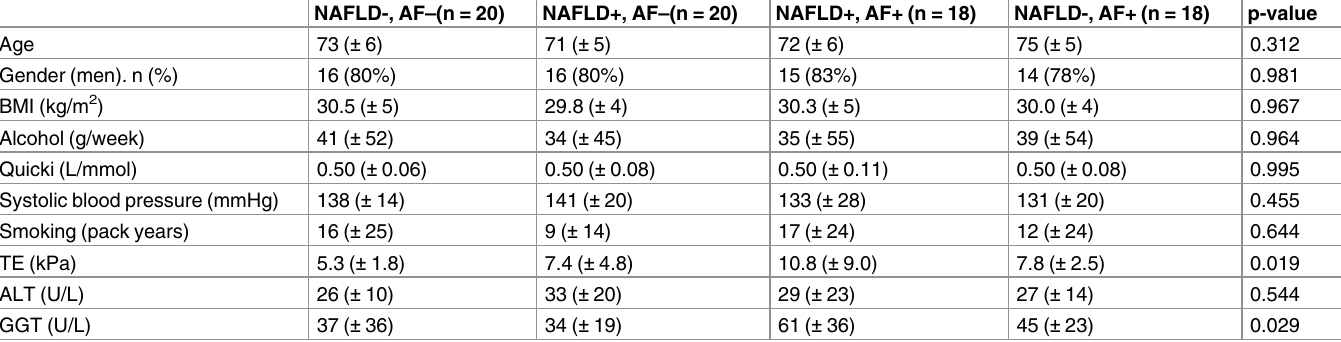
Table 2. The characteristics of the subjects with transient elastography (n = 76) by subgroups used in the study